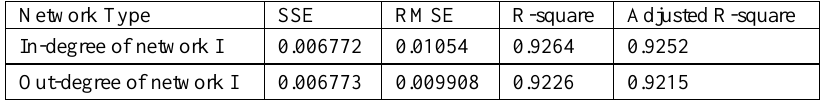
Table 1. The fitting results of degree distribution (95% confidence level). Network